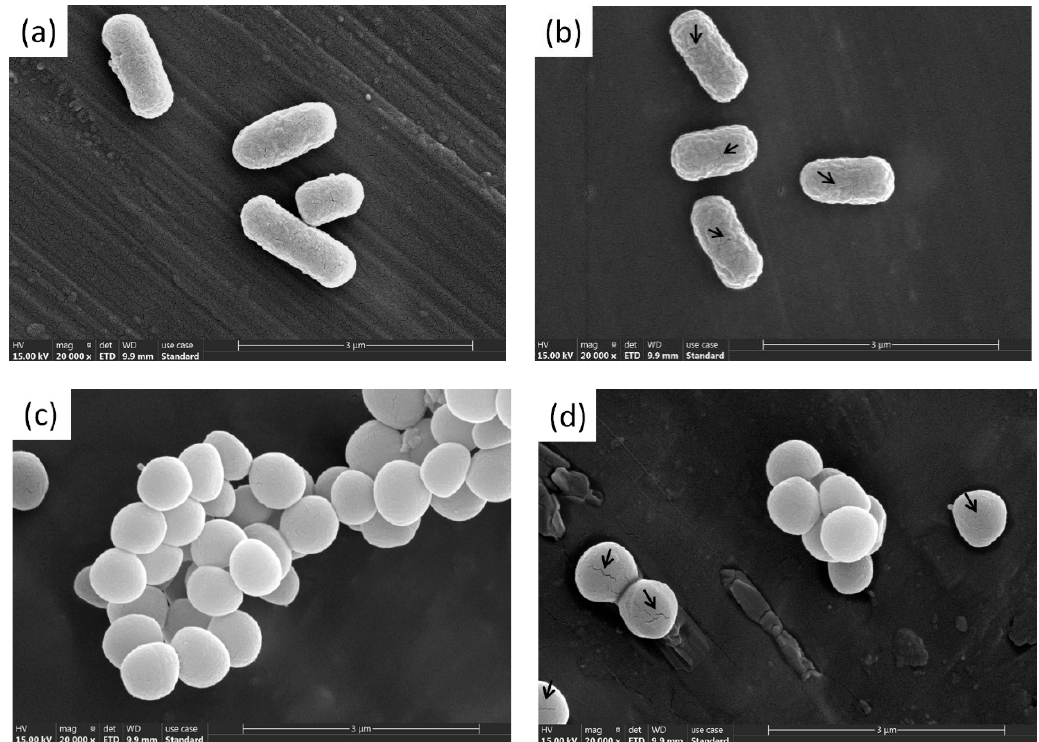
Figure 5. SEM observation of morphological changes of the tested bacteria (( a ) E. coli treated with negative control magnified 20,000×, ( b ) AgNP-treated E. coli magnified 20,000×, ( c ) S. aureus treated with negative control magnified 20,000×, ( d ) AgNP-treated S. aureus magnified 20,000×).